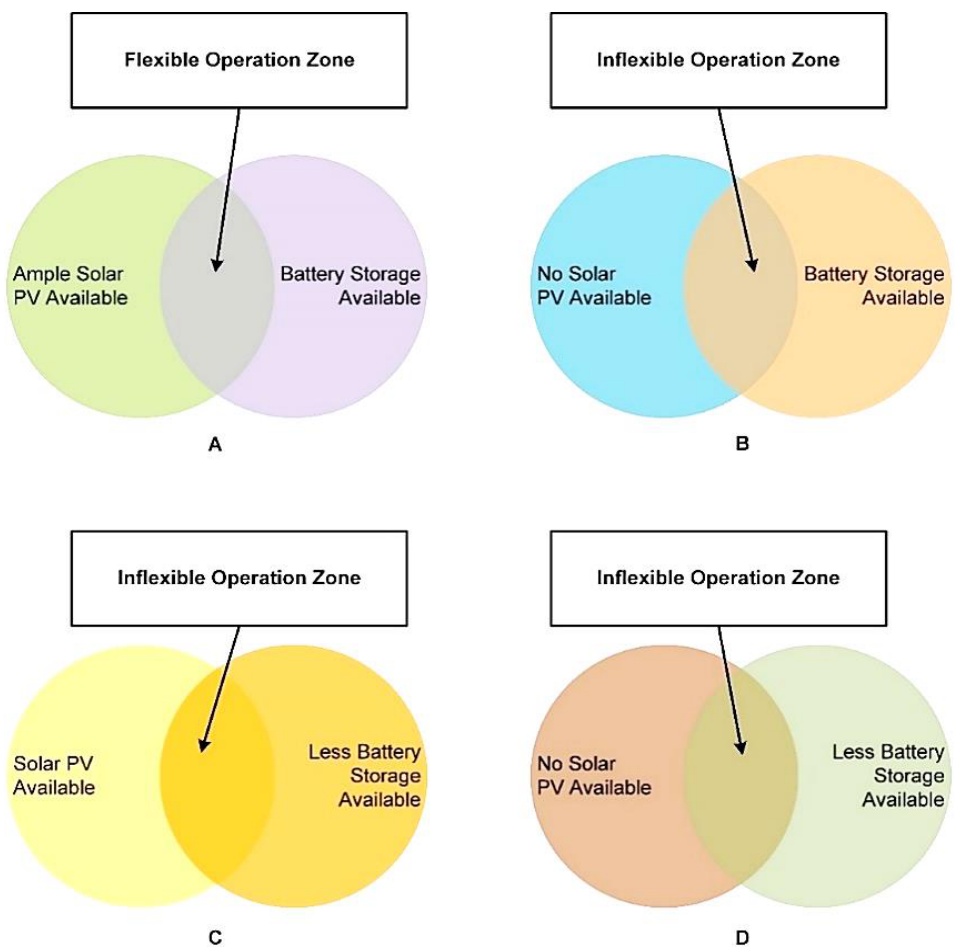
Figure 6. Zones of operation ( A ) shows the flexible zone of operation where ( B – D ) shows the in- flexible zones of operation